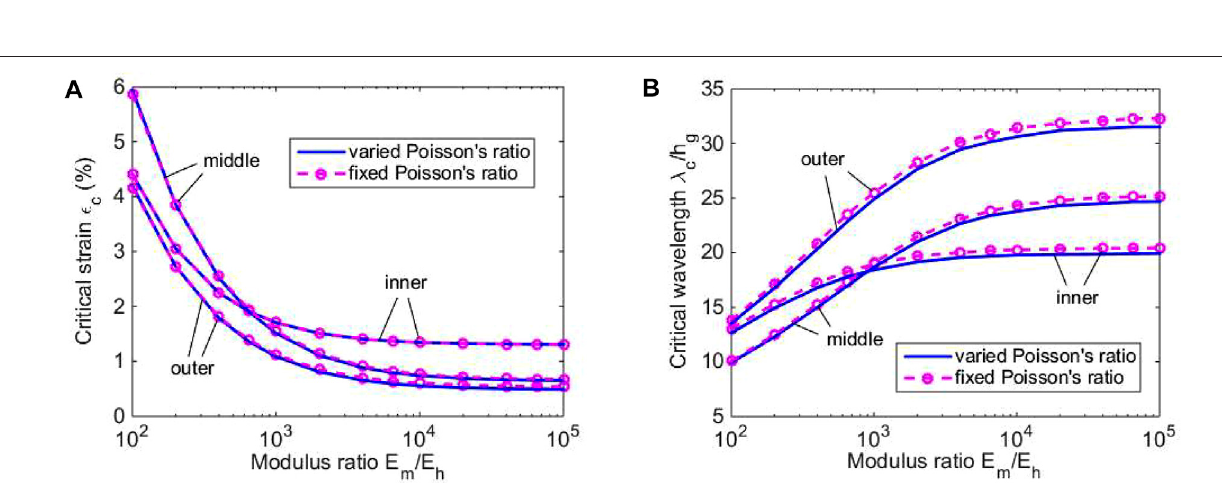
FIGURE 7 | (A) The critical strain and (B) the corresponding wavelength for soft cylinders with a linearly graded stiff layer as the inner, the middle, and the outer layers.